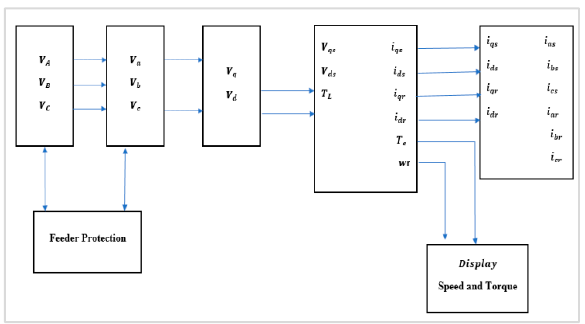
Figure 5. A proposed dynamic model of an induction motor.